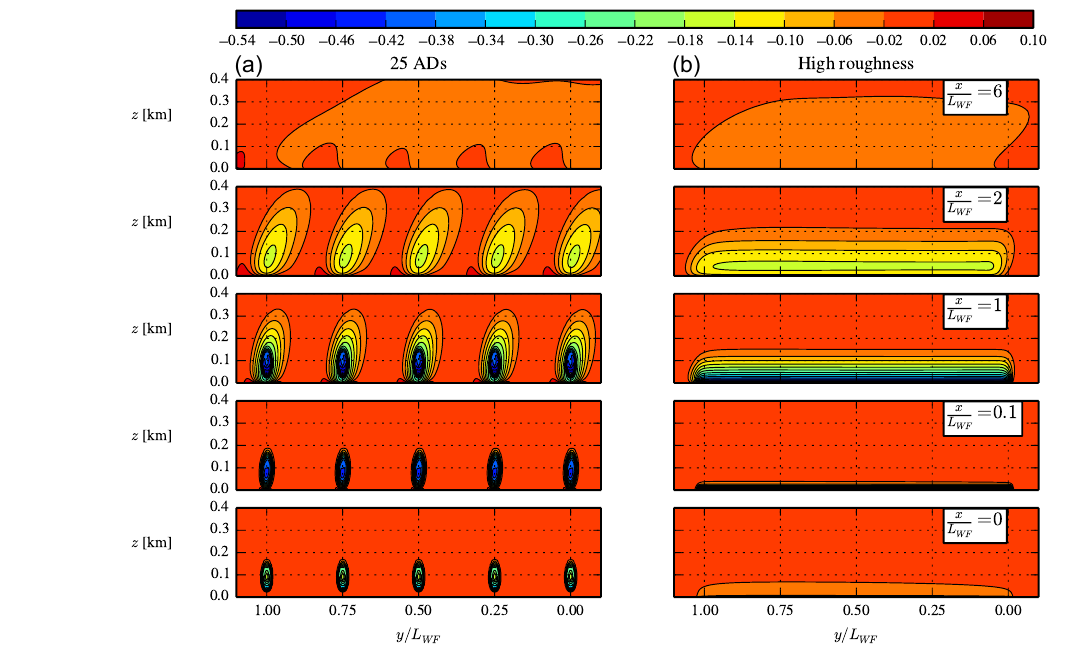
Figure 6. Stream-wise velocity subtracted and normalized by the free stream ( U − U inflow ) /U inflow at several downstream cross planes. (a) Wind farm is represented by 25ADs. (b) Wind farm is represented by a high roughness. Wind farm ends at x/L WF = 1.